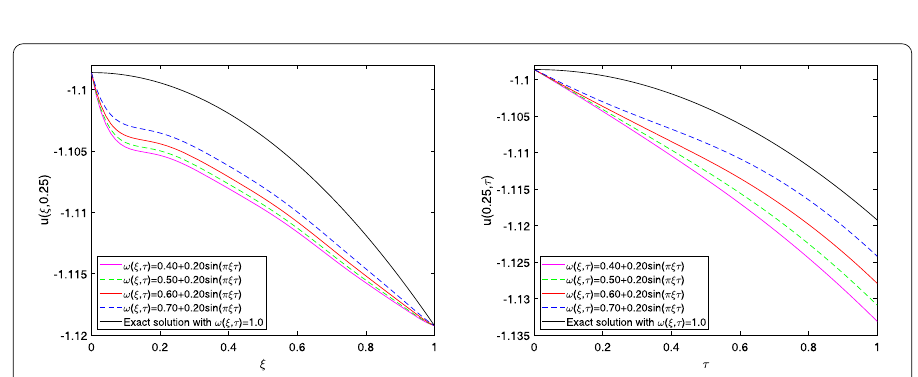
Figure 4 Behavior of the numerical solutions u ( ζ ,0.25) (left) and u (0.25, τ ) (right) where ( λ = 2, θ = 2) for some functions ω ( ζ , τ ) in Example